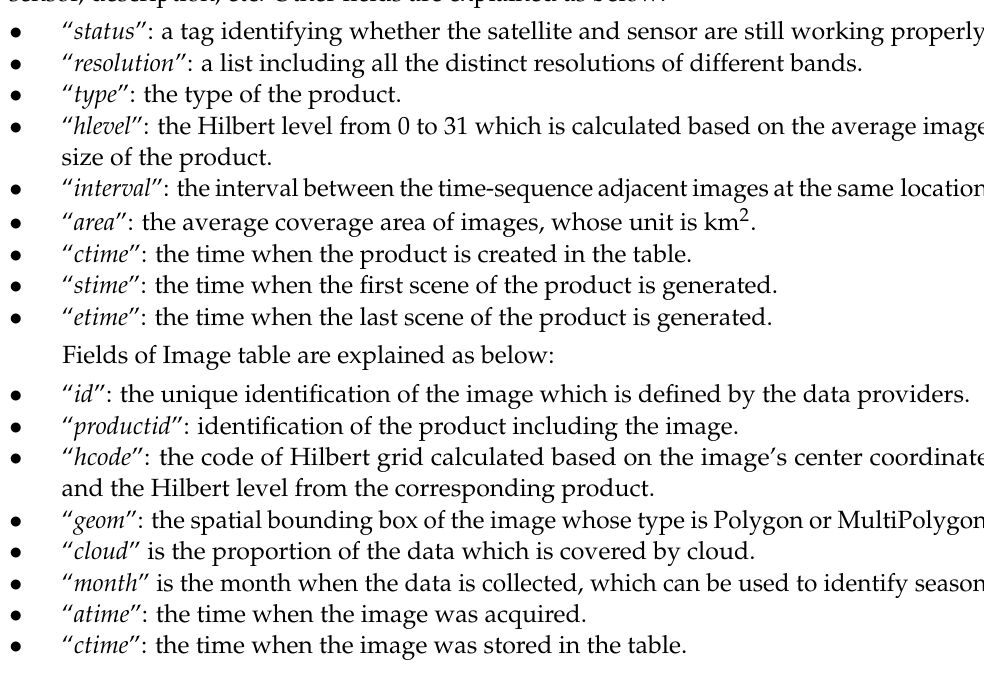
Figure 18. Structure of Image table.